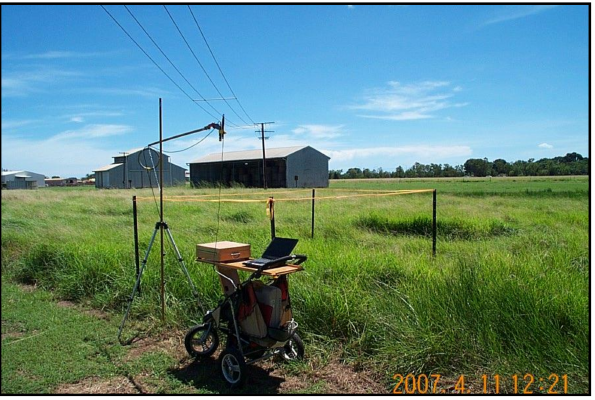
Figure 4. Standardised setup. Photograph of Digitaria milanjiana (BF04) taken 11 April 2007 while the grass is still green after wet season